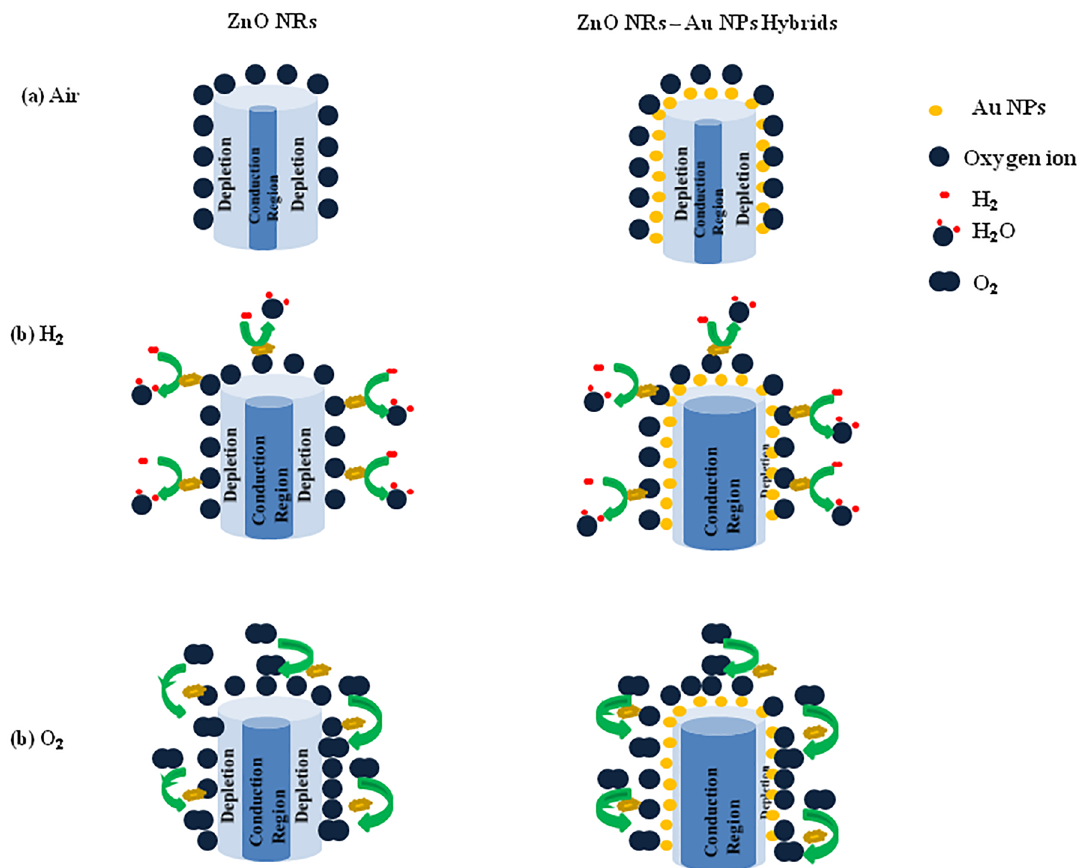
Figure 6. The gas sensing mechanism for sensor; a relative change in the depletion region of ZnO NRs and ZnO NRs- Au NPs hybrids in the presence of air,